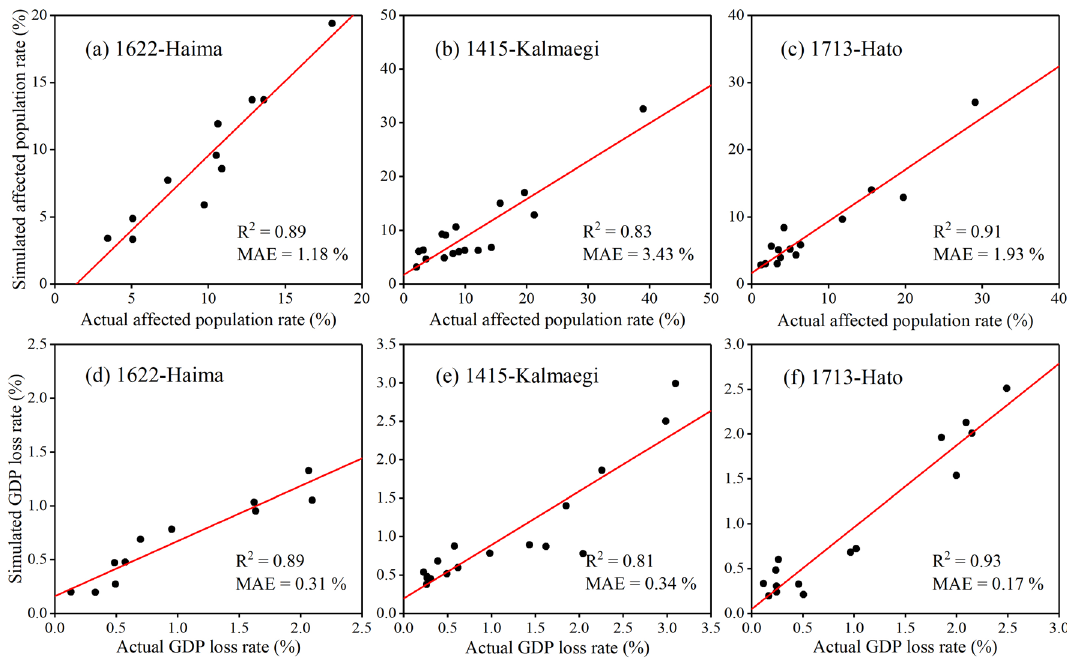
Fig. 5 Scatter plots of the simulated loss rates and reported ones for affected population and direct economic loss in each affected county for the three tropical cyclones. MAE = mean absolute